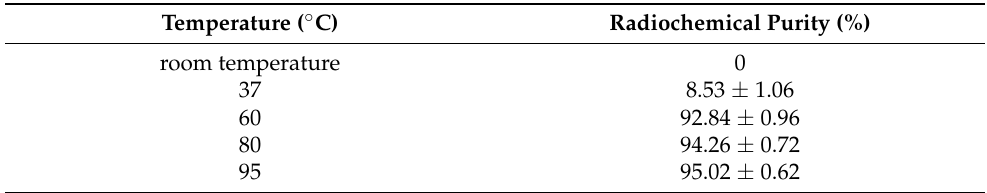
Table 2. Radiolabeling efficiency applying 32- µ M ligand concentration and 15 min reaction time at different temperatures ( n = 3).